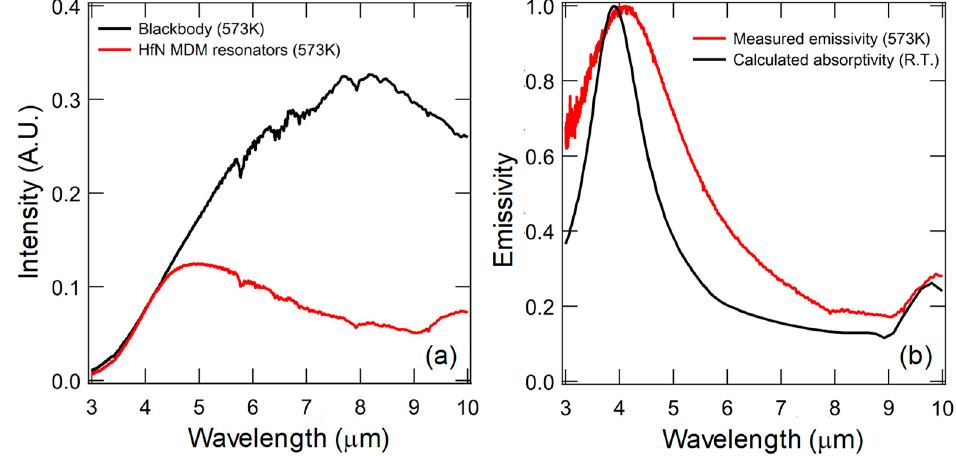
Figure 13. Experimental thermal radiation spectra for the MDM metasurface: ( a ) thermal radiation spectra for the MDM metasurface (red line) and blackbody reference sample (solid line) at 573 K. ( b ) Experimental spectral emissivity at 573 K (red line) derived from ( a ) and simulated absorptivity at room temperature (solid line).